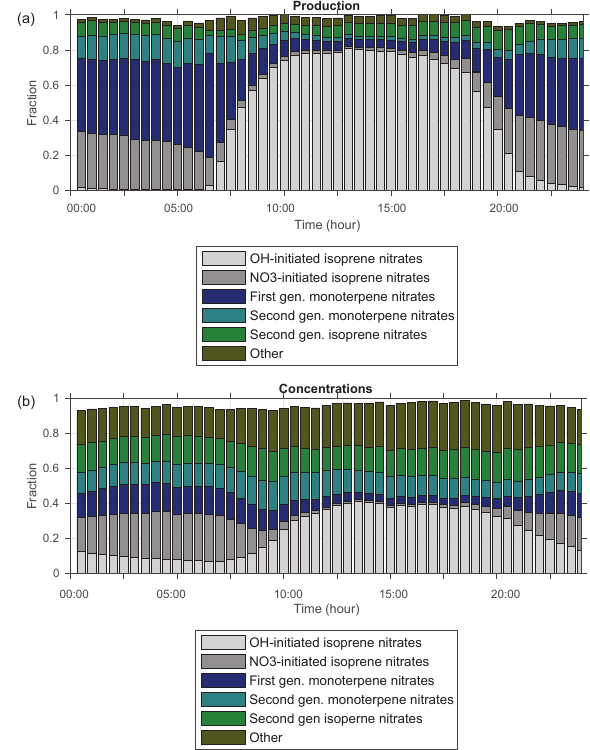
Figure 8. Diurnal cycle of fractional organic nitrate (a) production and (b) concentrations simulated by WRF-Chem averaged over the boundary layer at the CTR site during